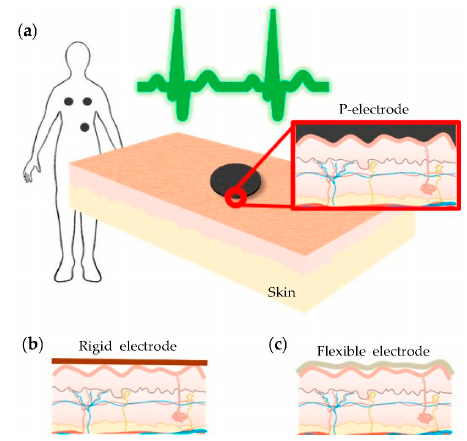
Figure 1. Schematic view of cross-section between the skin and various electrodes of ( a ) the proposed P-electrode; ( b ) a rigid electrode; and ( c ) a flexible electrode.